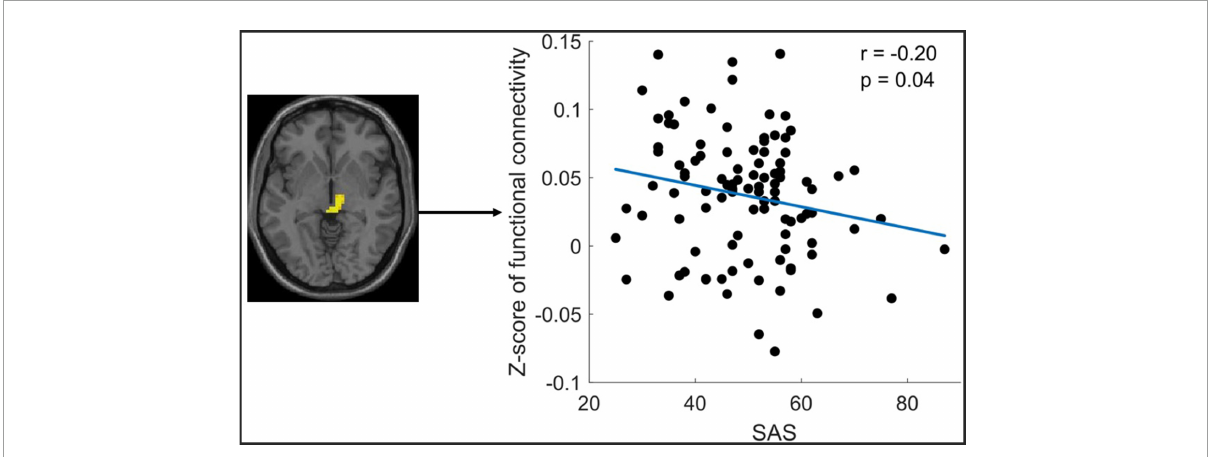
FIGURE4 Significant correlation between functional connectivity (FC) of Ch4-midbrain and self-rating anxiety scale (SAS). The figure shows the significant negative correlation between the z-scores of the FC between Ch4-midbrain and anxiety score. The mean Z-Score of the FC was extracted from the significant cluster of the